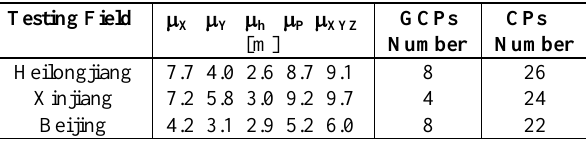
Table 4. Statistics of location accuracies with